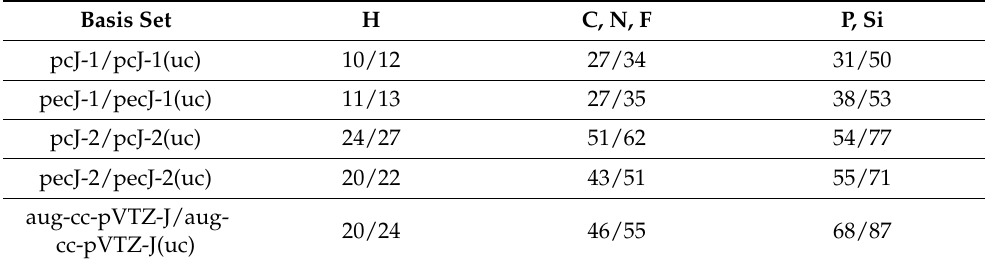
Table 4. The sizes of contracted and uncontracted basis sets under